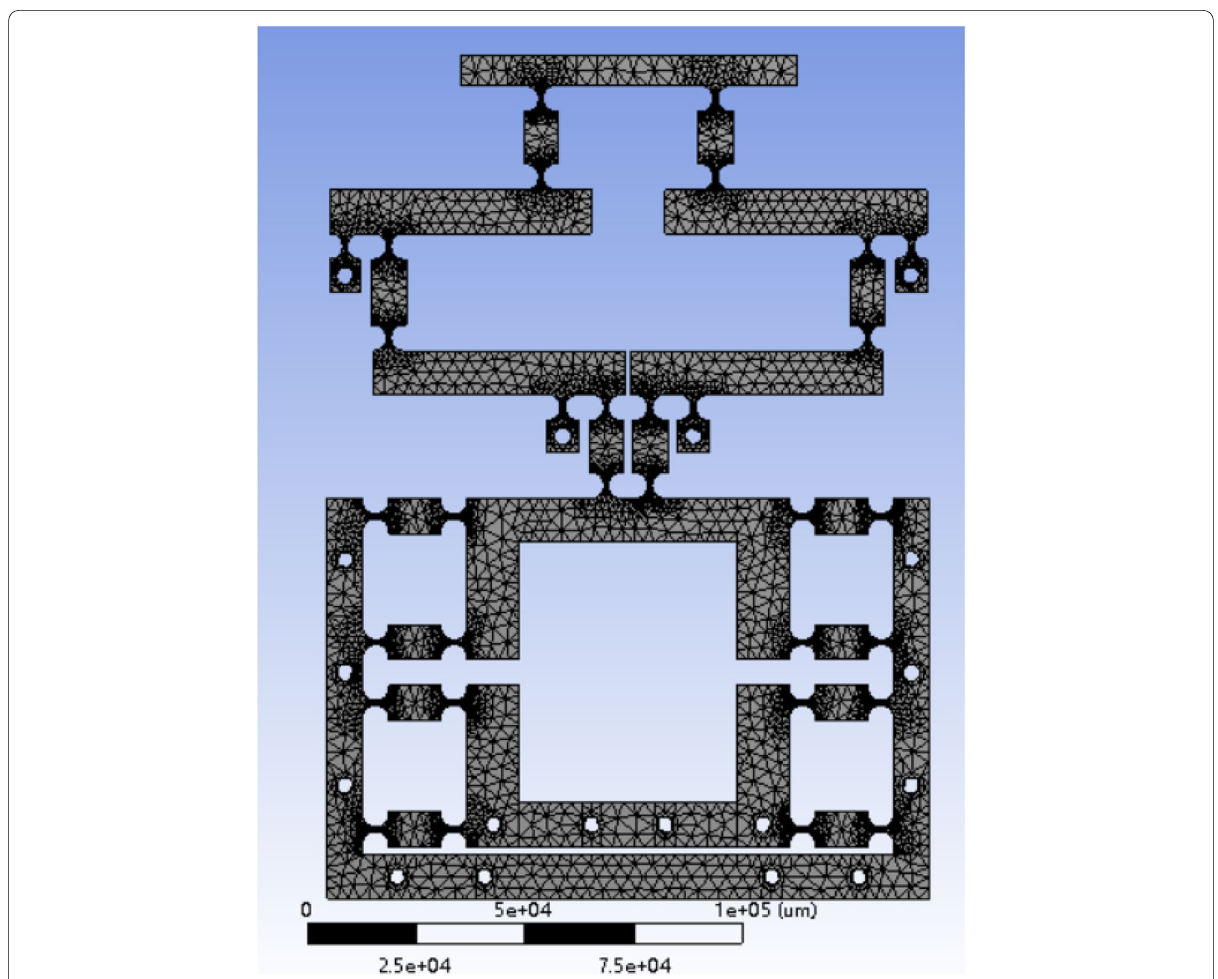
Fig. 7 Meshing diagram of micro-drive